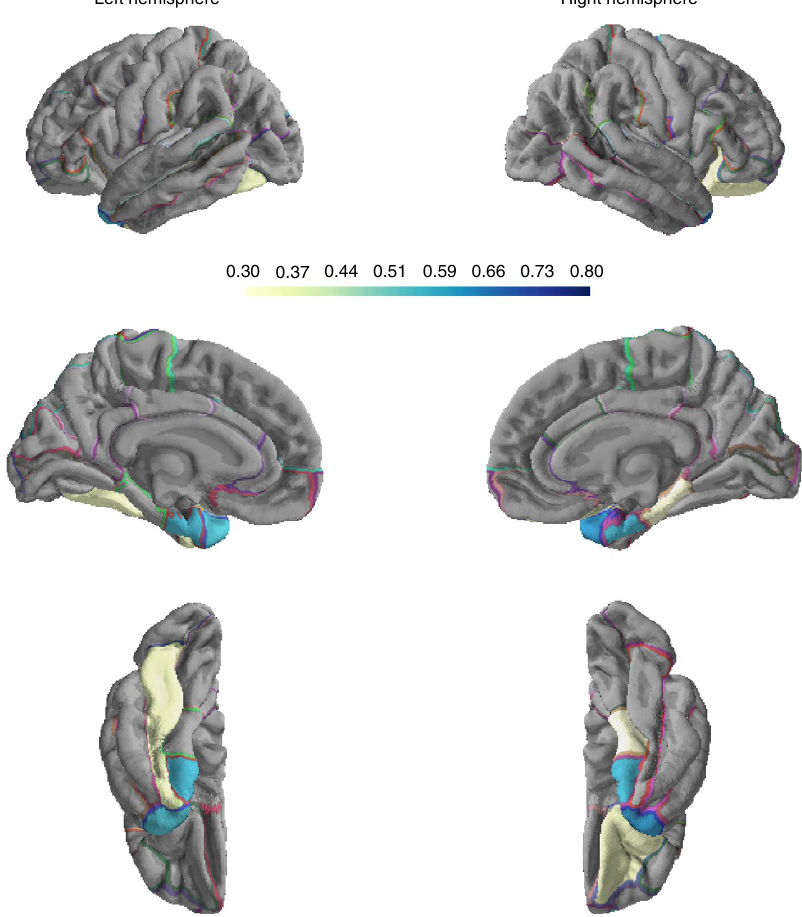
Figure 4 | Regional cortical thickness loadings on factor F6 associated with ICA2 methylomic profile. Absolute values for loadings are considered. Loadings o |0.3| are not